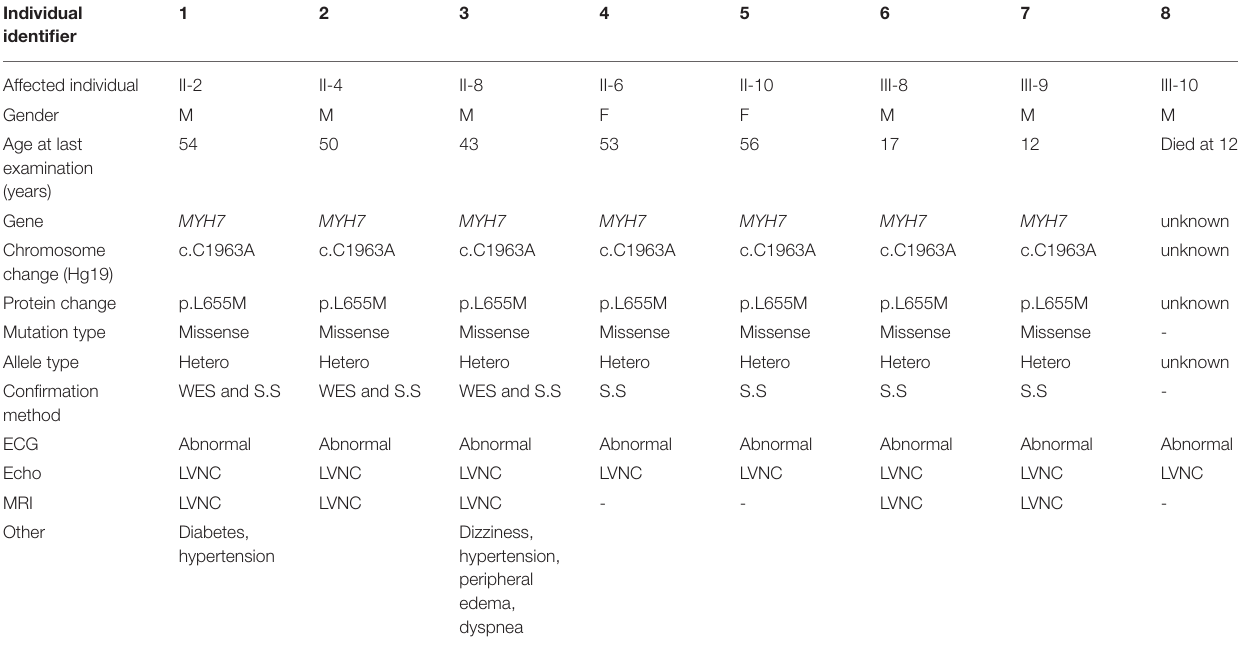
TABLE 1 | Overview of clinical features of LVNC in the affected family